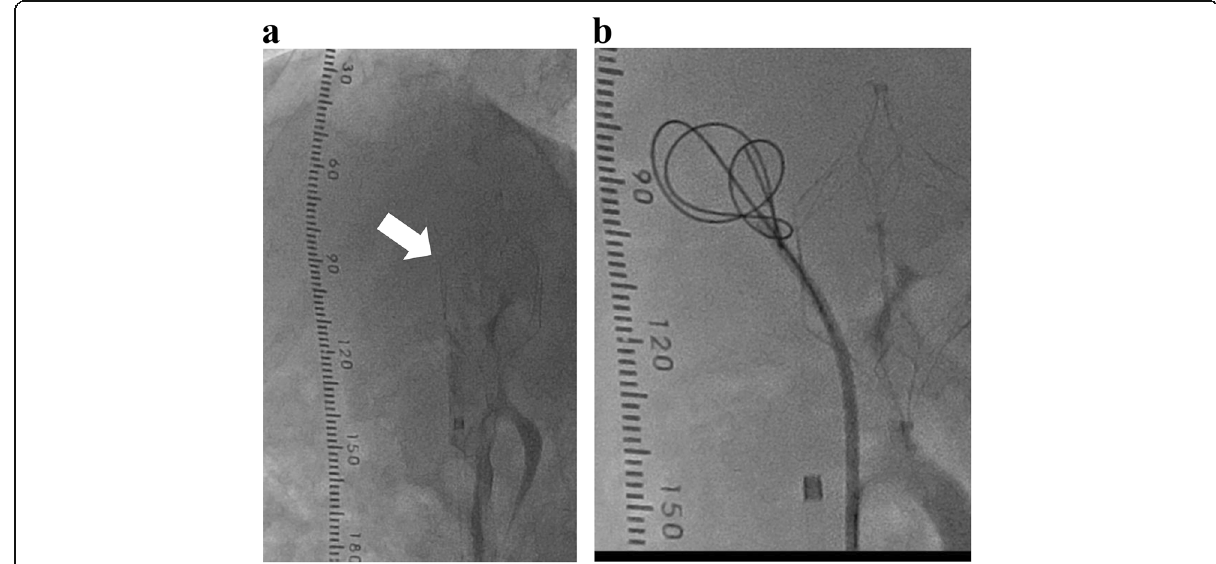
Fig. 3 Coil embolization following placement of the IVC filter (white arrows)